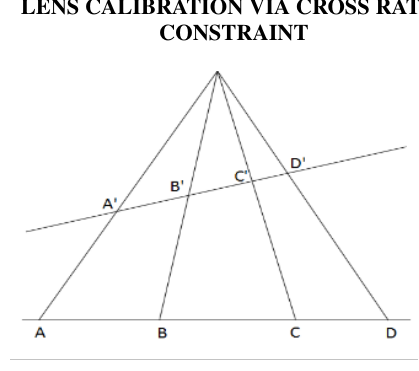
Figure 1: Principle of cross-ratio invariablity